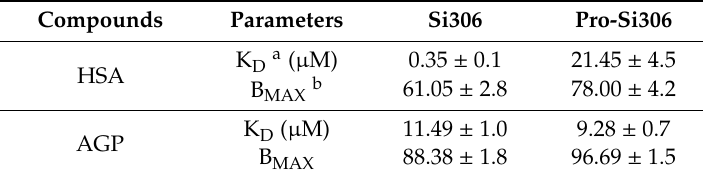
Table 4. Plasmatic proteins binding parameters for Si306 and pro-Si306.